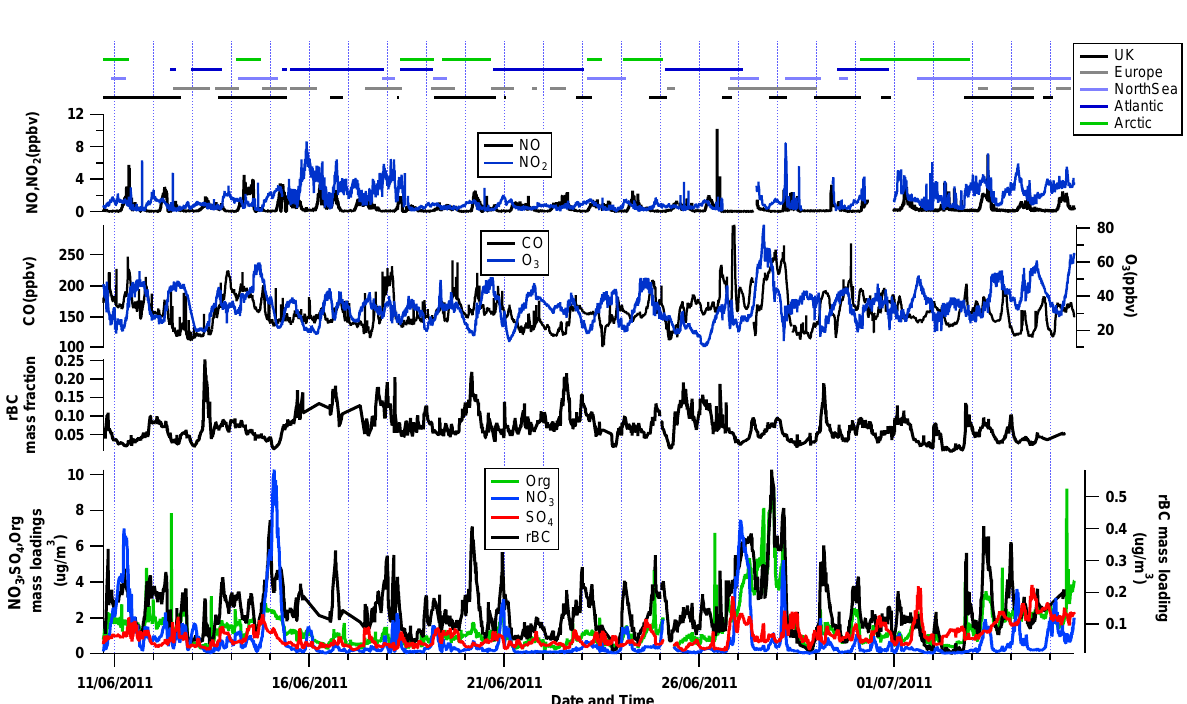
Fig. 3. An overview of aerosol masses, trace gas concentrations measured at WAO during the experiment. The classifications of air mass history are according the regional air mass contributions obtained from the 3-day NAME dispersion model footprints (Fleming et al.,